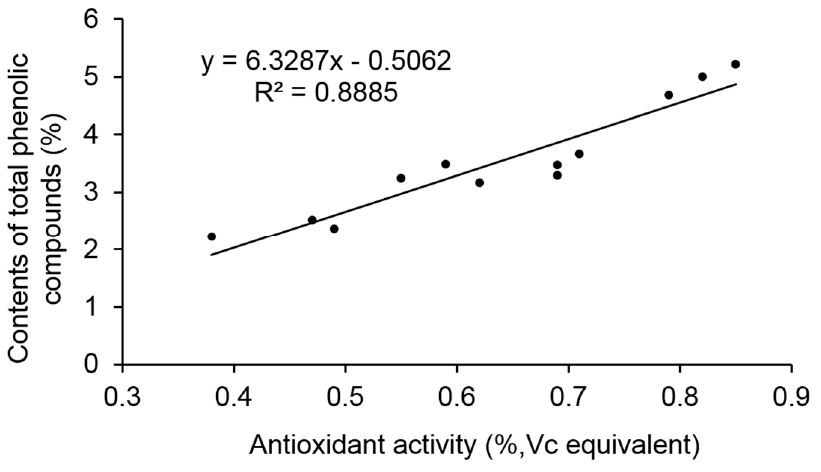
Figure 3. Linear correlation analysis between antioxidant activity and contents of total phenolic compounds in different samples.